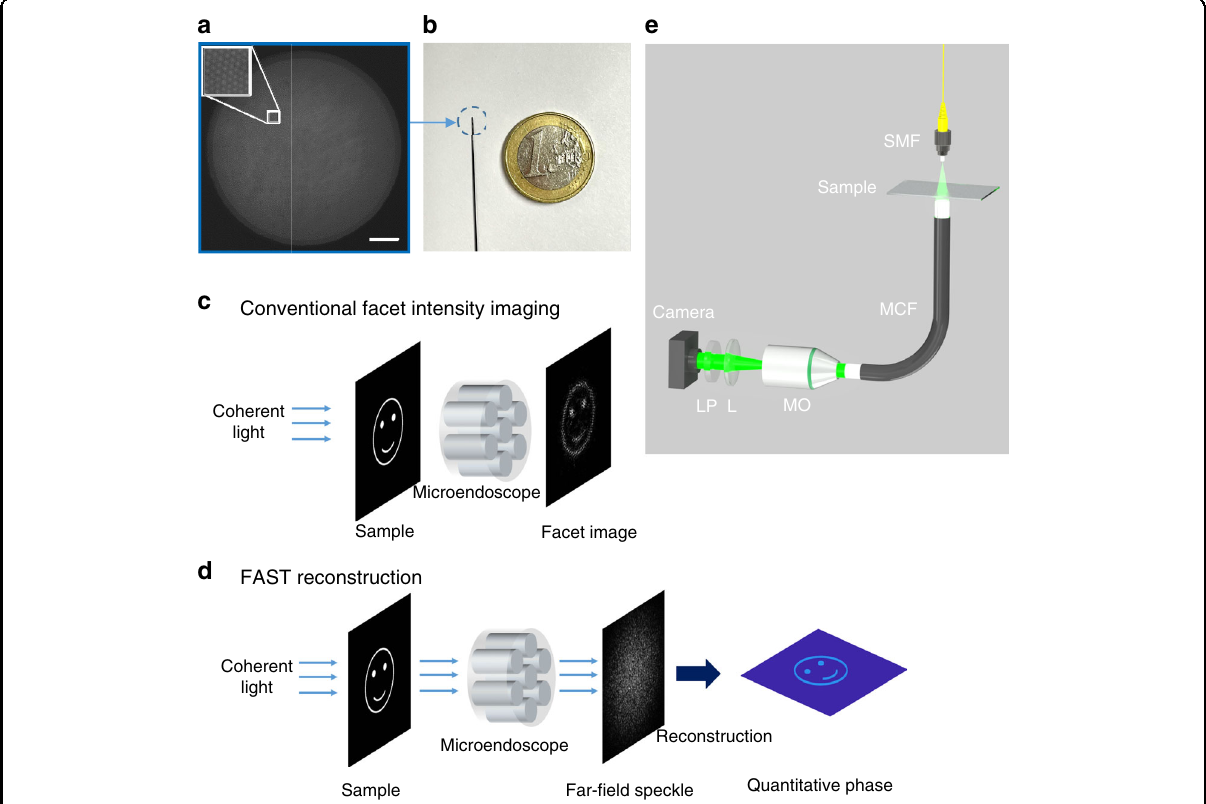
Fig. 1 Lensless quantitative phase microendoscope: setup and concept. a Microscopic image of the tip facet of the 10,000 core fi ber bundle with a diameter of 350 μ m. Scale bar 50 μ m. b Photo of the fi ber bundle and a one euro coin for scale. c Conventional lensless microendoscopic imaging can only get the pixelated intensity information of the specimen, and the sample has to be very close to the fi ber facet. d Quantitative phase and high-resolution amplitude images of the specimen can be reconstructed from the far- fi eld speckle image. The sample can be placed far from the facet due to the digital focusing capability. e Experimental setup; SMF single-mode fi ber, MO microscope objective, L achromatic lens, LP linear